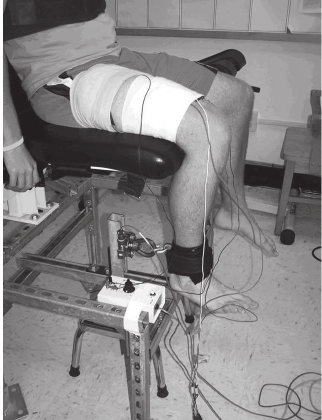
Figure 2: The setup for measuring quadriceps torque generation and surface EMG